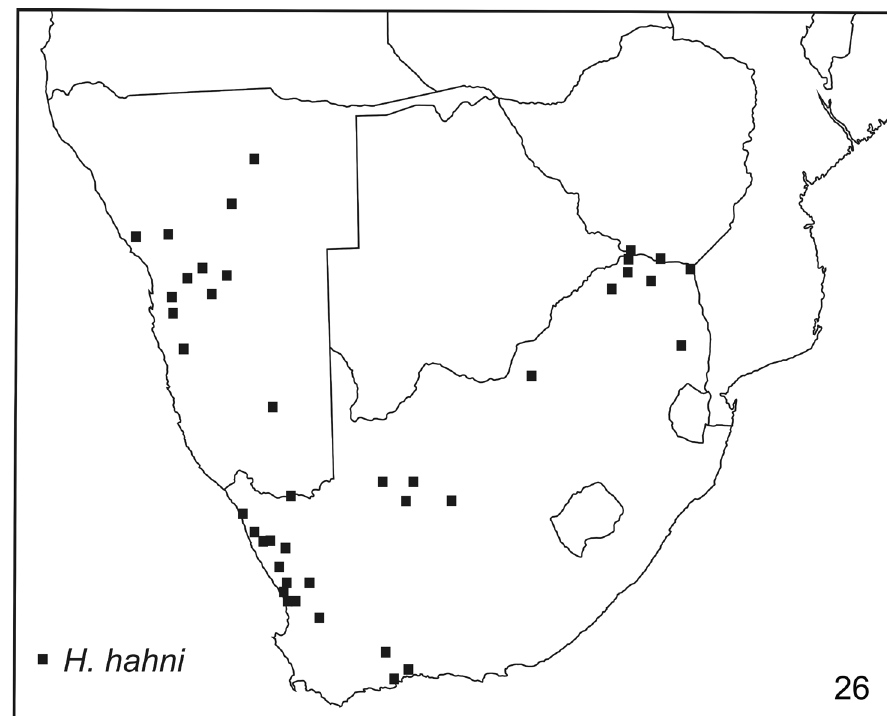
Fig. 26. Distribution map for Hexophthalma hahni (Karsch,